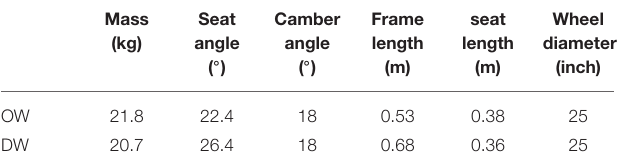
TABLE 2 | Wheelchairs